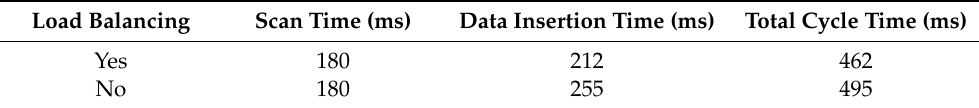
Table 1. Total BL-detector mean scanning time and data recording time using a single MongoDB instance and a load balancing switch that connects to a redundancy clustered MongoDB service . Load Balancing Scan Time (ms) Data Insertion Time (ms) Total Cycle Time (ms) Yes 180 212 462 No 180 255